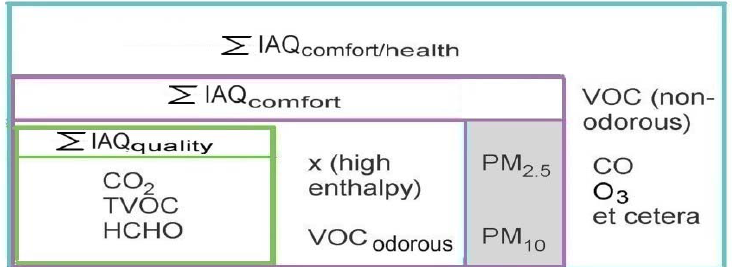
Figure 3. ∑ IAQ model has three possible levels (i.e., similar to a Russian doll structure) adapted to the potential applications of the model.